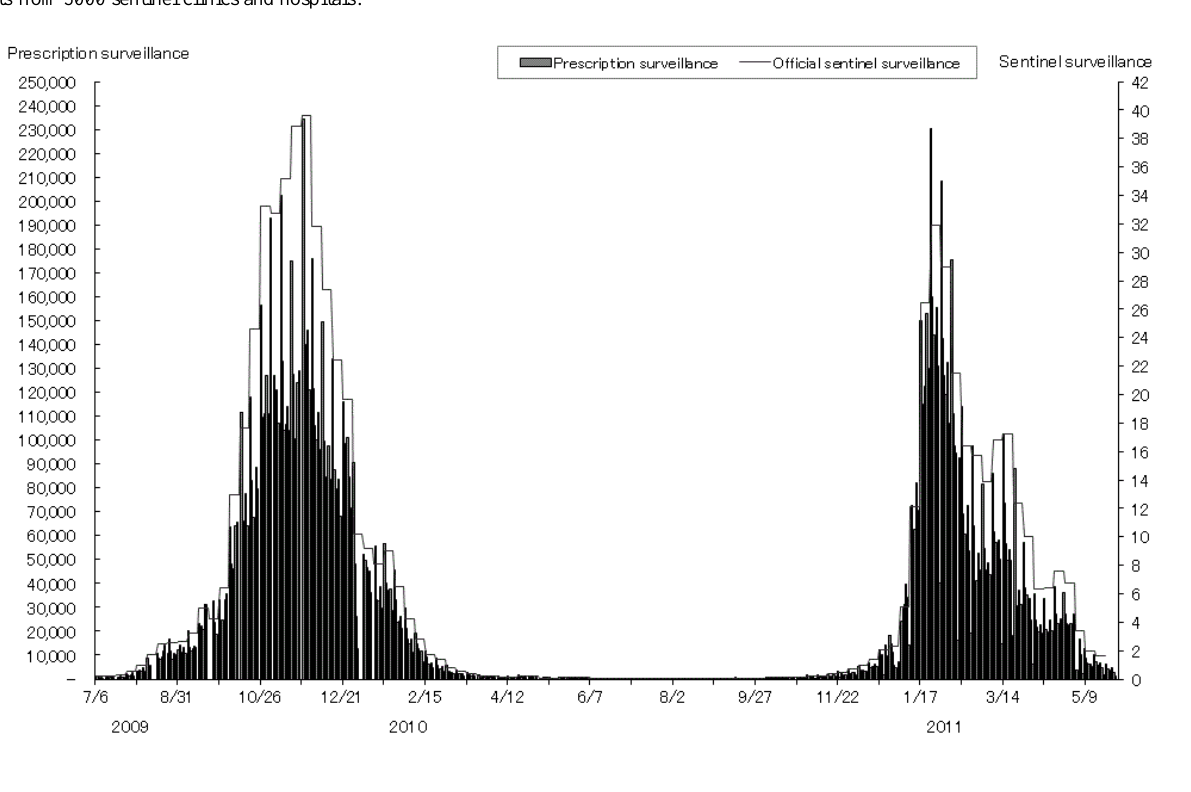
Figure 2. Number of influenza cases, 2009–2011, estimated by the prescription surveillance and reported by the official sentinel surveillance. The estimated number of influenza cases by prescription surveillance was calculated based on the number of oseltamivir, zanamivir, and laninamivir prescriptions adjusted by the proportion of participating pharmacies and extramural dispensing percentage. See text for details. The reported number by the official sentinel surveillance shows the number of influenza patients per clinic or hospital, calculated with the reported number of influenza patients from 5000 sentinel clinics and